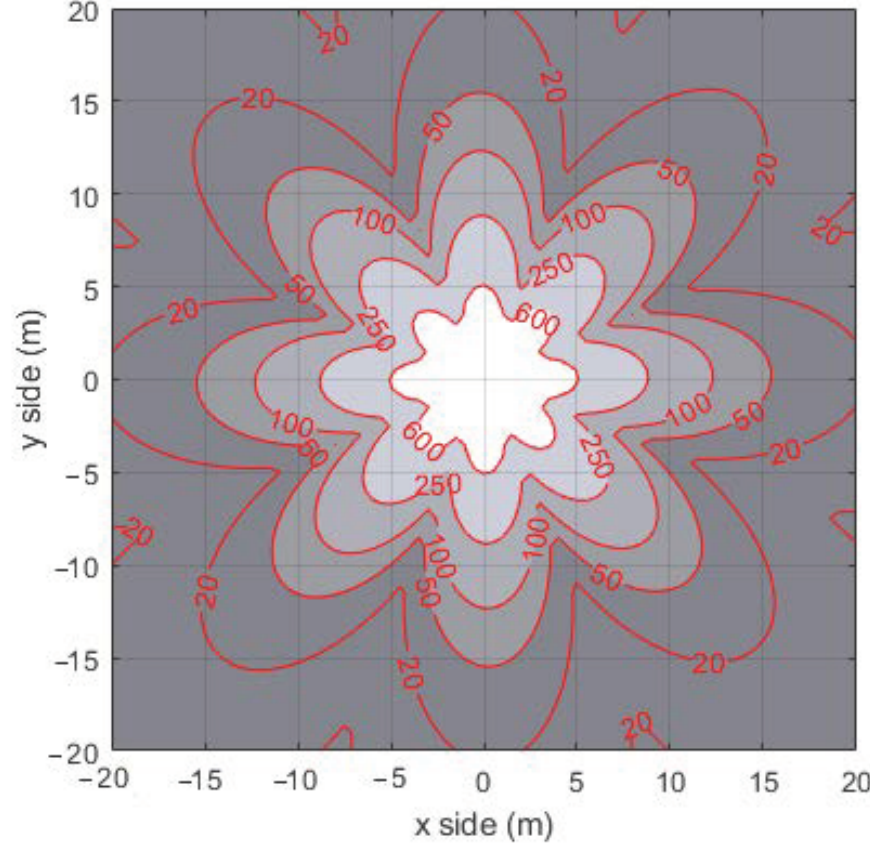
Figure 5. Planar distribution of RF power converted in DC (I DC in